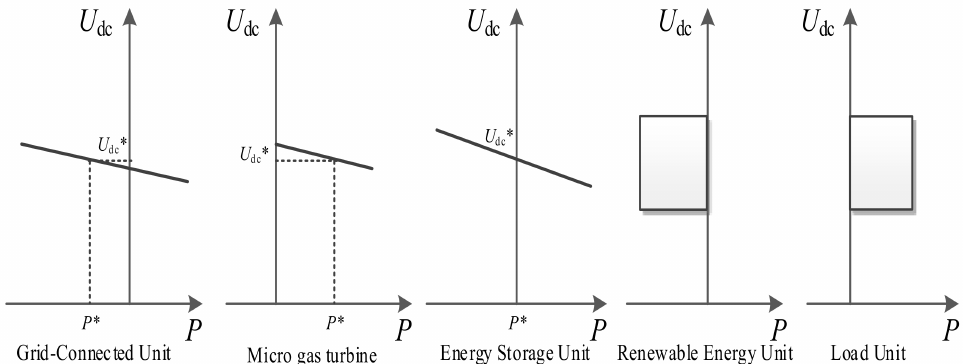
Figure 5. Coordinated control for equipment in the DC micro-grid.